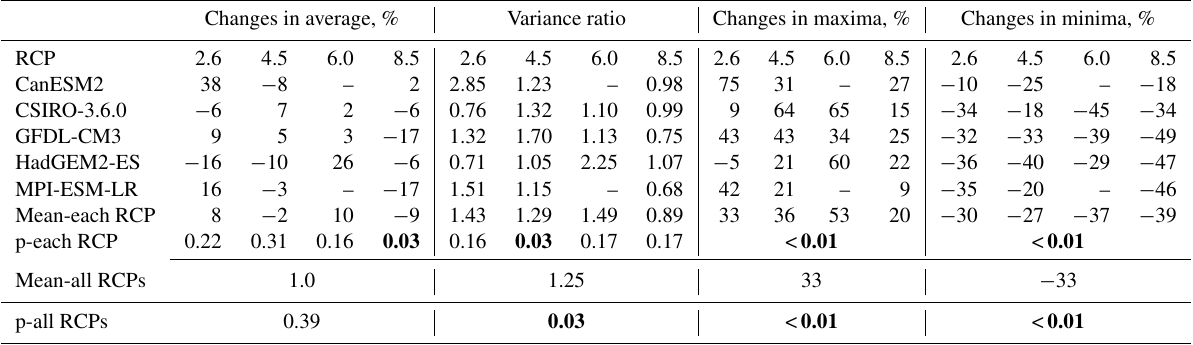
Table 4. Changes in average and variance of annual streamflow and mean monthly extreme streamflow during the 2020s relative to 1961– 2005.